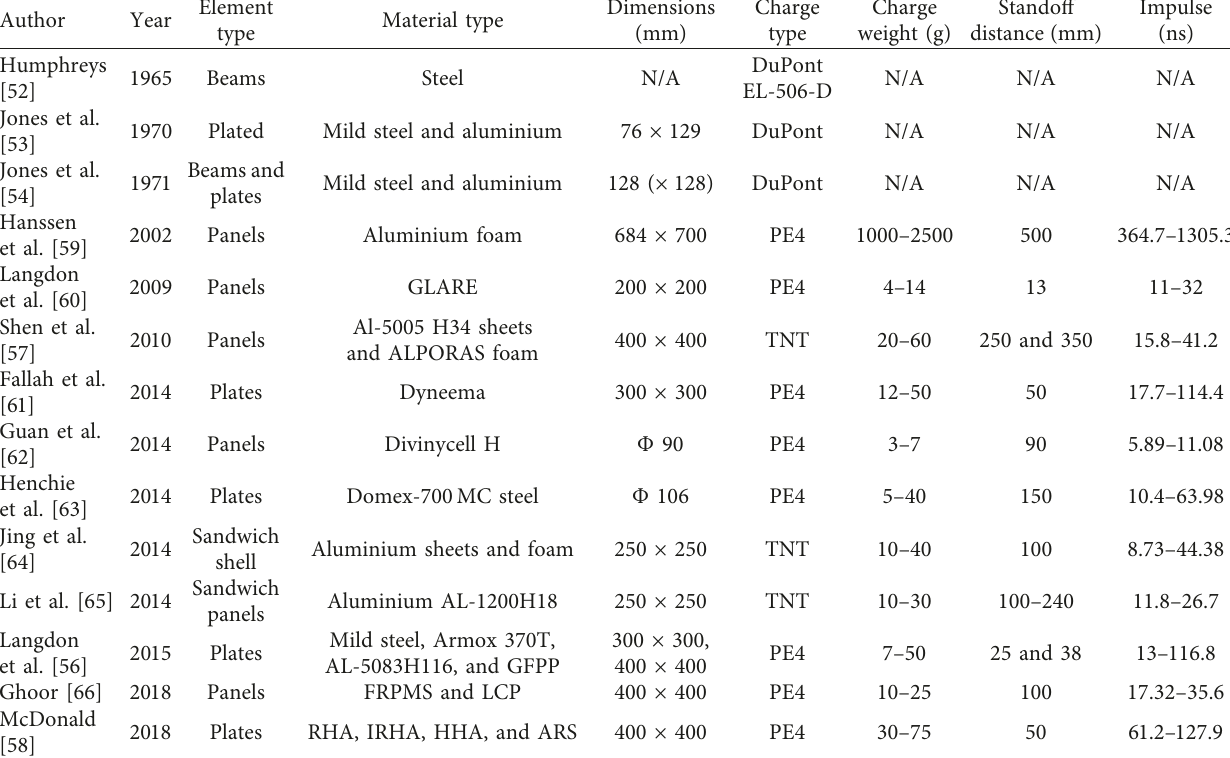
Table 3: Blast pendulum tests.